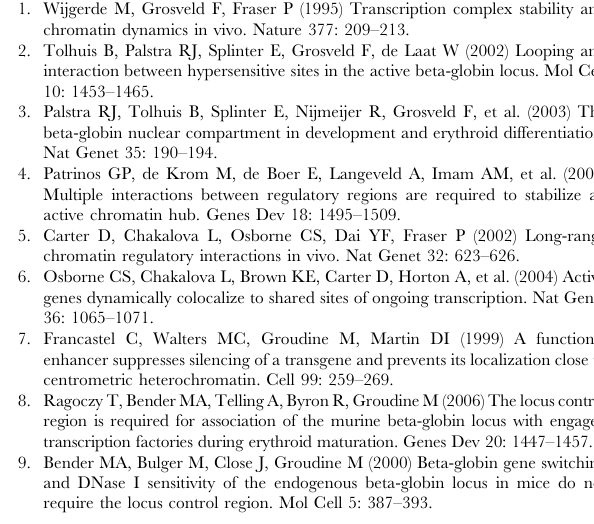
Figure S3 The cHS4 dimer core recombines into a monomer after lentivirus transfer. PCR amplification using primers that overlap the insulator-LTR junctions demonstrates presence of a monomer cHS4 core element.